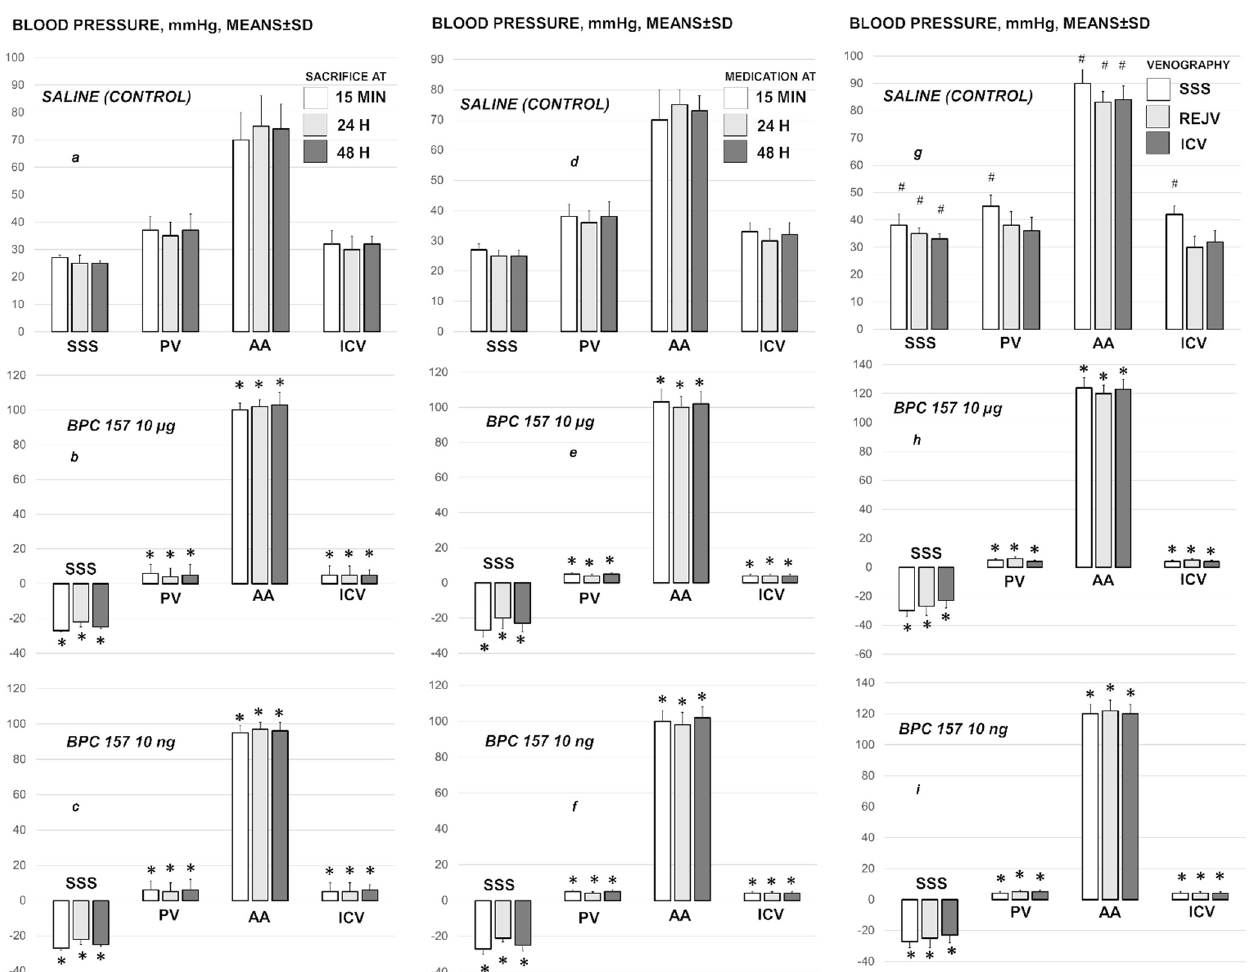
Figure 5. Blood pressure of the rats with ligated superior sagittal sinus in the superior sagittal sinus (SSS), portal vein (PV), abdominal aorta (AA) and inferior caval vein (ICV), at the end of the 5 min assessment following medication (BPC 157 10 µg/kg, 10 ng/kg; saline 5 mL/kg) given intraperitoneally. Early medication at 1 min ligation time, blood pressure assessment before euthanized at 15 min ( a ), 24 h ( b ) and 48 h ( c ) ligation time. Delayed medication at 15 min ( d ), 24 h ( e ) and 48 h ( f ) ligation time. ( g – i ) For verification of the effect of venography, assessment at 5 min upon the additional 1 mL of saline application in the superior sagittal sinus (SSS), right external jugular vein (REJV) or inferior caval vein (ICV), inducing venous hypertension additionally originated within the cranium, inside the sinus lumen, neck or abdomen, at 15 min, and subsequent immediate ip application of saline or BPC 157. Similar effects were obtained with BPC 157 intragastric or local application at the swollen brain (data not specifically shown). Means ± SD, * p < 0.05, at least vs. control; # p < 0.05, at least vs. regular saline-control in non-venography studies.